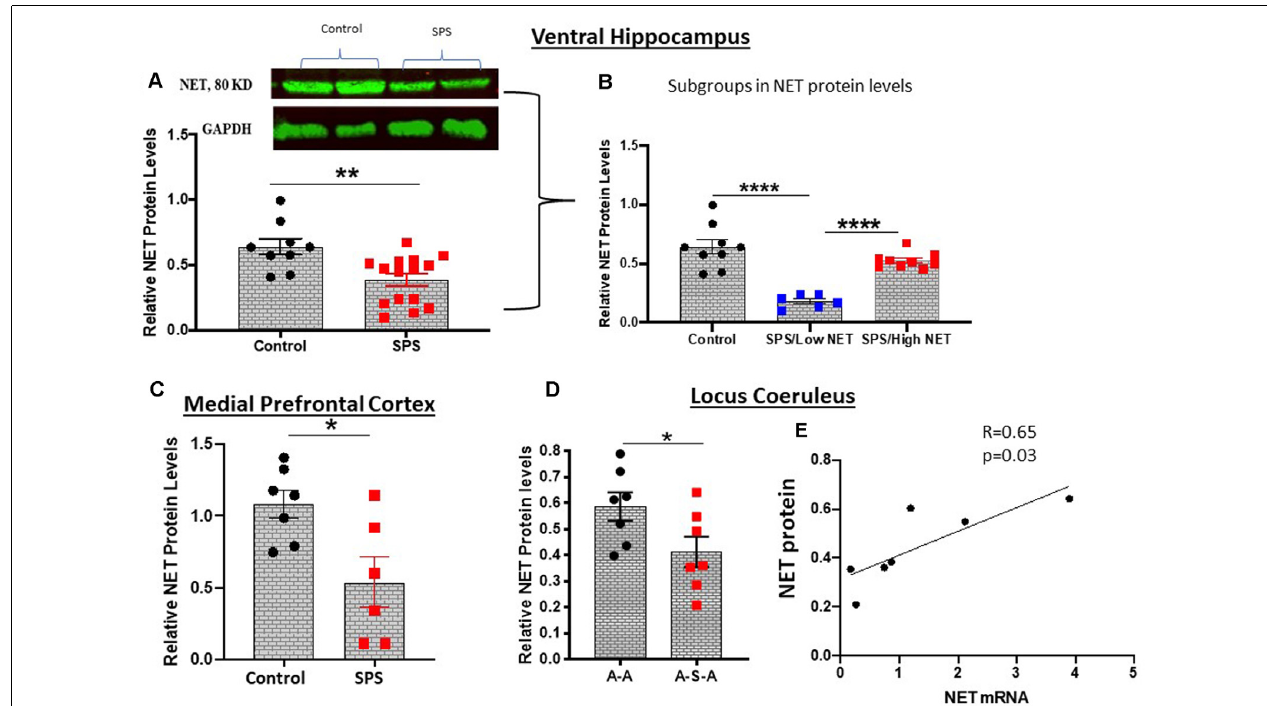
FIGURE 3 | SPS triggered changes in NET protein expression. NET protein levels were evaluated by western blot analysis in the ventral hippocampus 4 weeks after SPS stressors (Experiment 2). A representative western blot and summary data for all the animals (A) or when subdivided into high and low NET levels (B) are shown. In a different cohort of animals (Experiment 4), NET protein was determined in the medial prefrontal cortex 2 weeks after SPS stressors (C) . Relative NET protein levels in LC of the A-A and A-S-A subgroups from Experiment 3 are shown (D) . NET protein was correlated to NET mRNA in the A-S-A group ( r = 0.65, p = 0.03) (E) . Each dot represents an individual animal, * p < 0.05, ** p < 0.01, **** p < 0.0001.